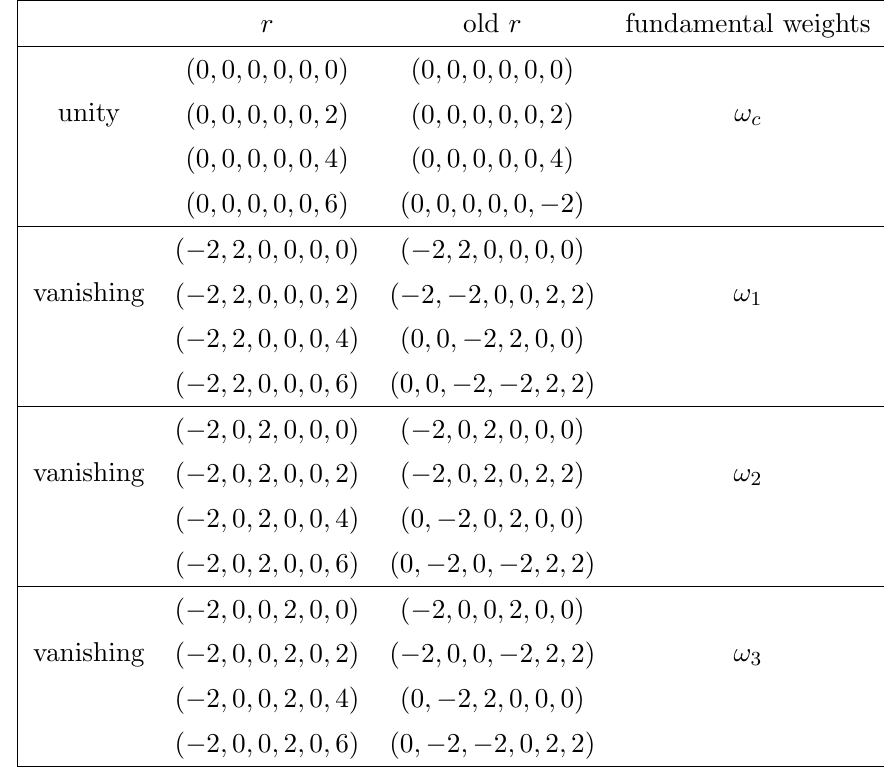
Table 7 . The r -(cid:12)elds of the n = 4 model and the fundamental weights of d 4 which induce the embedding (cid:30) : Q _ , ! P . The old r -(cid:12)elds are from our previous paper [25]. They are equivalent with the r in the second column by 2 C (cid:1) n